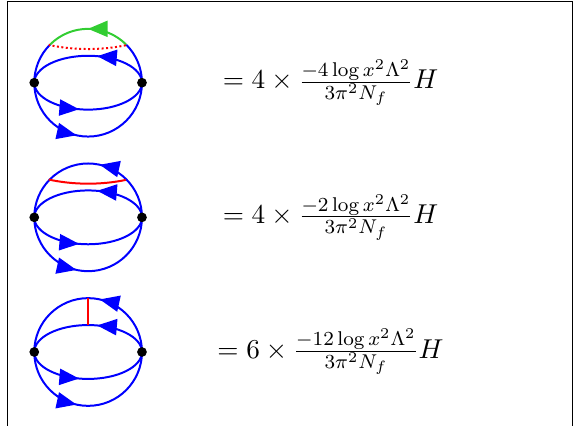
Table 16 . ( N = 2 SQED) quartic adjoint-2 operator renormalization. Dotted red line stands for the e(cid:11)ective gaugino (cid:21) 2 propagator. Thick red line stands for e(cid:11)ective D-(cid:12)eld